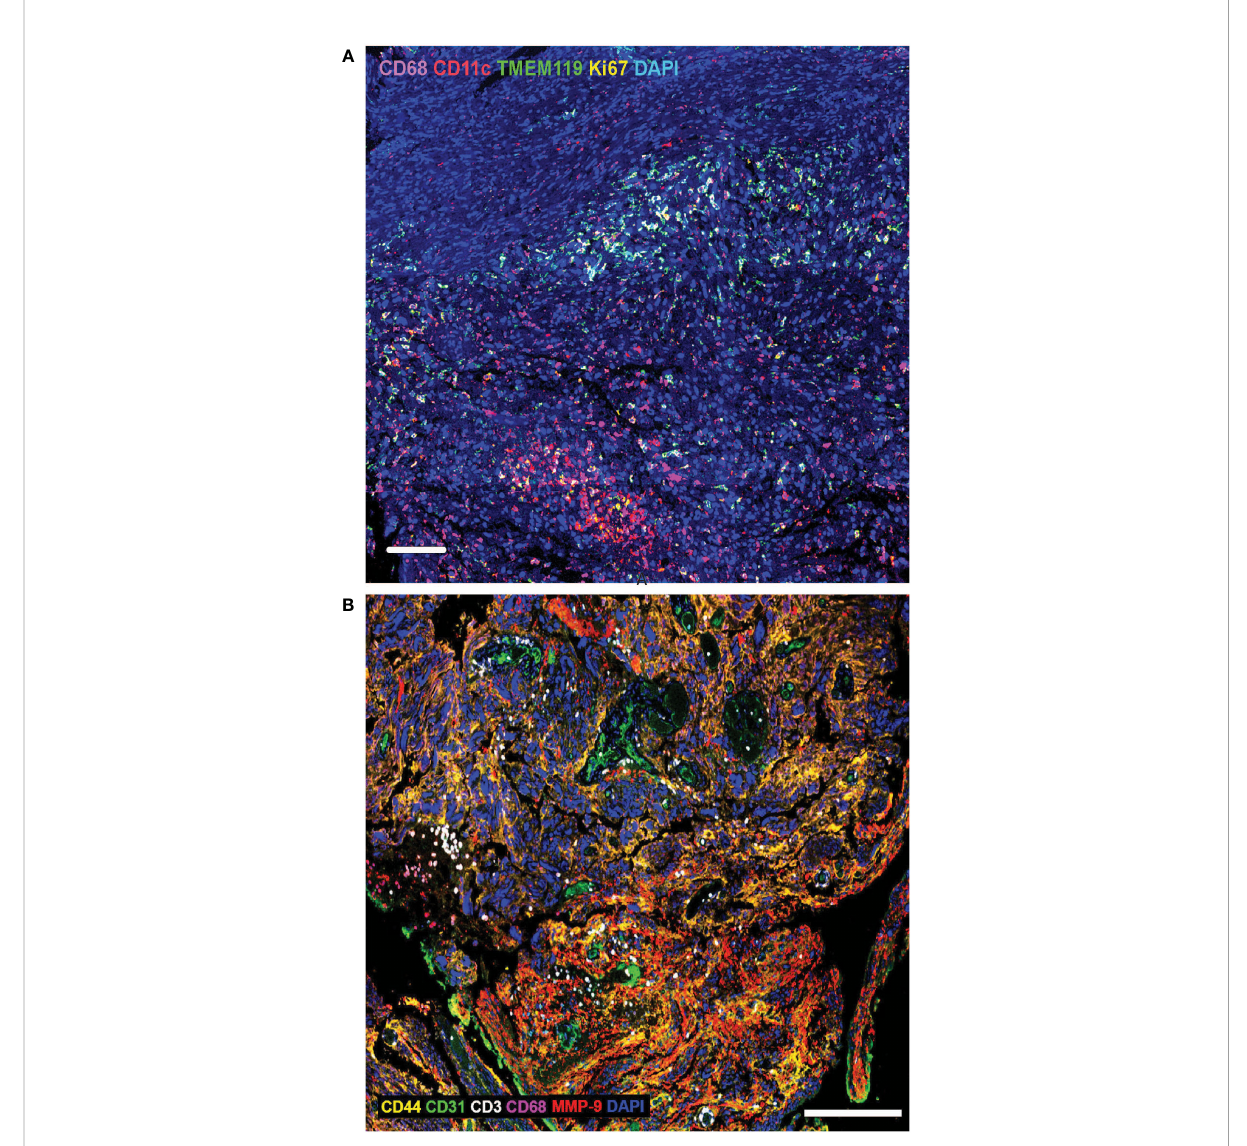
FIGURE 1 (A) Extensive heterogeneity and distinct spatial distribution of immune cells in paediatric brain tumour microenvironment. Multiplex immunohistochemistry analysis of paediatric high-grade glioma tissue using biomarkers to identify macrophages (CD68), dendritic cells (CD11c), microglia (TMEM119) and proliferating cells (Ki67). DAPI labels all cell nuclei. Tumour in fi ltrating immune cells are often present in clusters, with macrophages penetrating deeper into tumour cell-rich regions, compared with dendritic cells and microglia. Scale bar is 100 µ m. (B) Extensive heterogeneity and distinct spatial distribution of T-cells and macrophages in adult brain tumour microenvironment. Multiplex immunohistochemistry analysis of adult glioblastoma tissue using biomarkers to identify tumour cells (CD44), endothelial cells/blood vessels (CD31), T-cells (CD3), macrophages (CD68), matrix metalloproteinase-9 (MMP9); DAPI labels all cell nuclei. Tumour in fi ltrating T-cells are often present in clusters, in close proximity to blood vessels, while macrophages penetrate deeper into tumour cell-rich regions. Scale bar is 200 µ